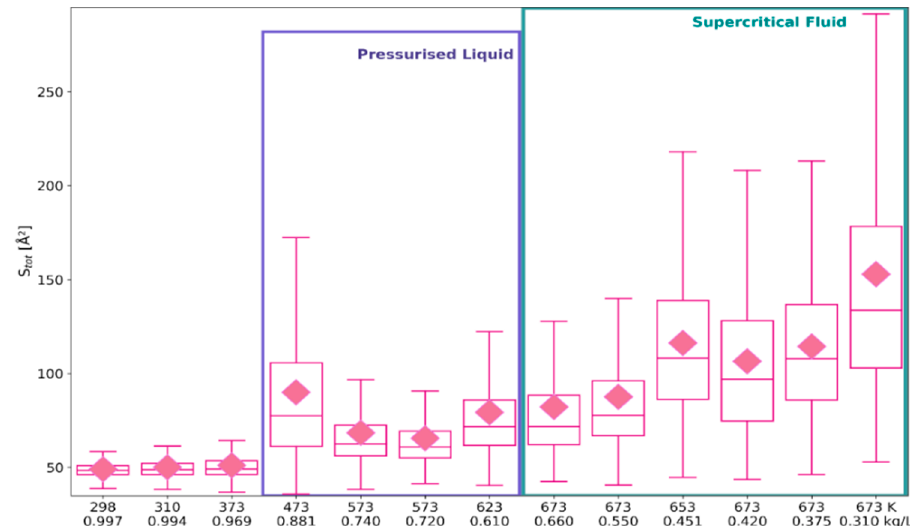
Figure A1. Box-and-whiskers plots displaying median, 1st and 3rd quartiles, minimum (bottom whisker), maximum (upper whisker), and means (points) of statistical distributions of VP-volume obtained for the thermodynamic states defined by temperature and density, as in Table 1.